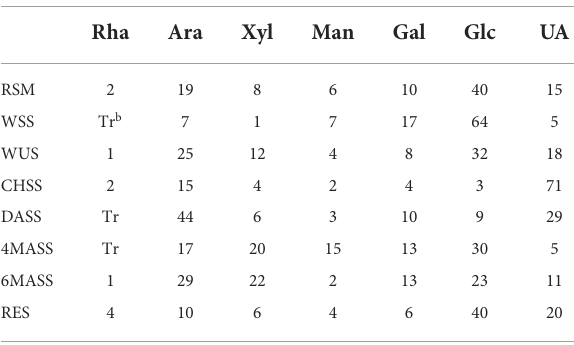
TABLE 2 Molar sugar composition of RSM fractions a